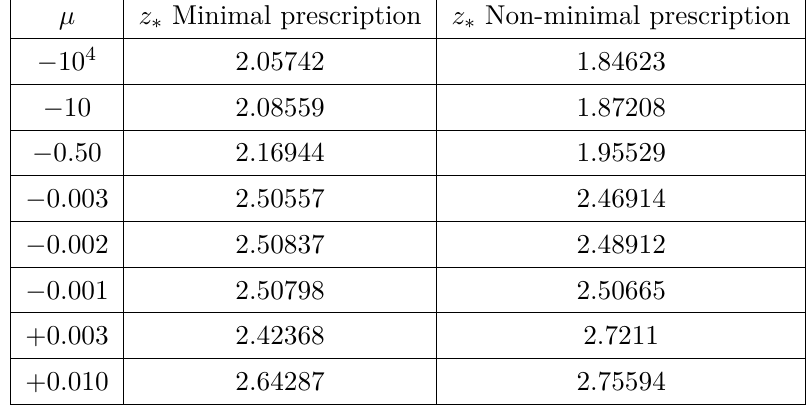
Table 1 . Values of z ∗ obtained from numerical solutions, for different values of µ .